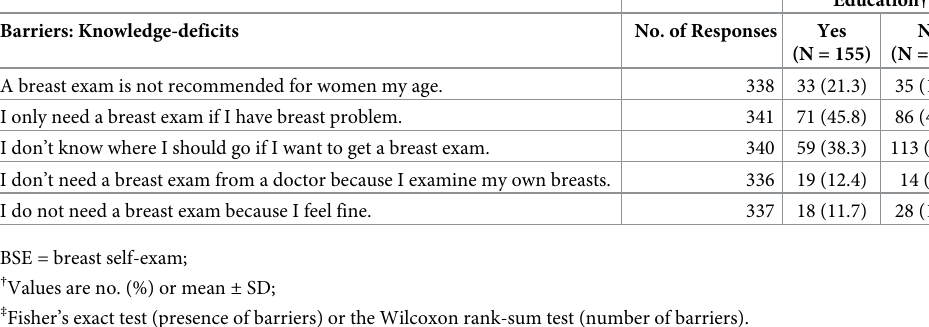
(S3 Table). After the setting and age adjustments, associations between BSE and agreement with the statements “I only need a breast exam if I have a breast problem” (p = 0.030) and “I do not need a breast exam because I feel fine” (p = 0.027) became marginally statistically signif- icant while they were marginally not statistically significant during the unadjusted compari- sons in Table 4 (p = 0.087 and p = 0.11, respectively).